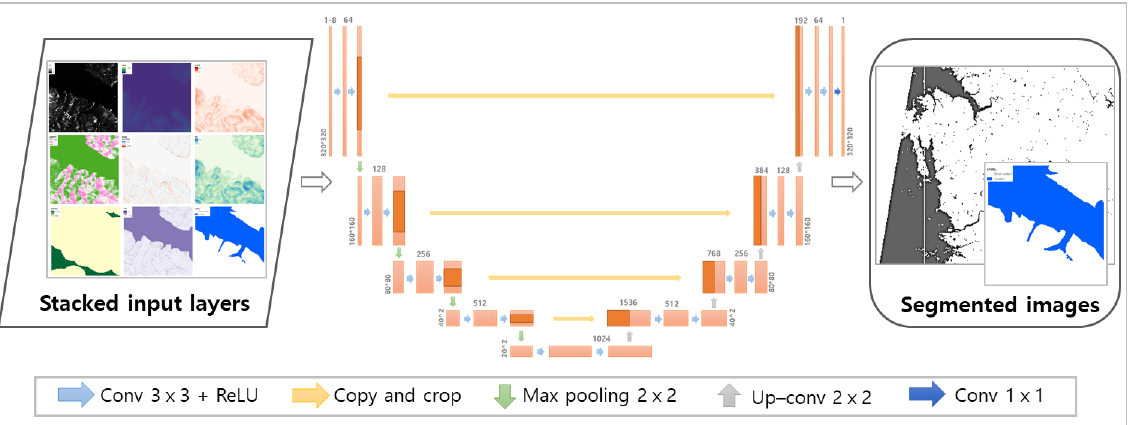
Figure 5. Architecture of the optimized deep neural network for multilayered input image segmen-